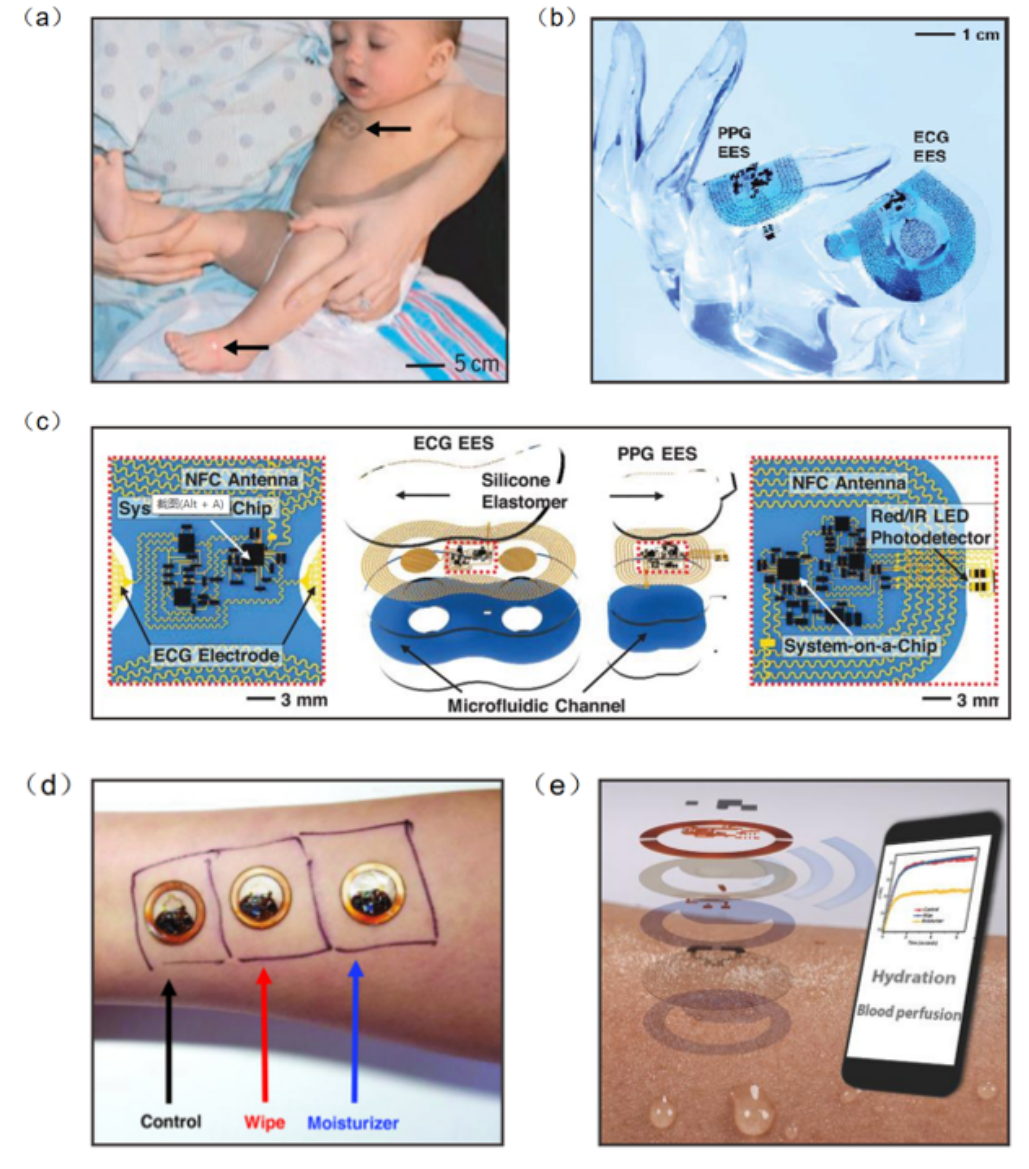
Figure 10. ( a ) A neonate with an ECG device on the chest [98]. ( b ) The device can be overlaid on a life-size finger [98]. ( c ) Schematic illustration of wireless, battery-free modules for recording ECG and PPG data and skin temperature [98]. ( d ) Wireless measurements of skin hydration on human subjects [107]. ( e ) Exploded-view schematic illustration of an epidermal wireless thermal sensor [107]. ( a – c ) Reprinted with permission from Ref. [98]. Copyright© 2022, The American Association for the Advancement of Science. ( d , e ) Reprinted with permission from Ref. [107]. Copyright© 2022, WILEY-VCH Verlag GmbH & Co. KGaA,